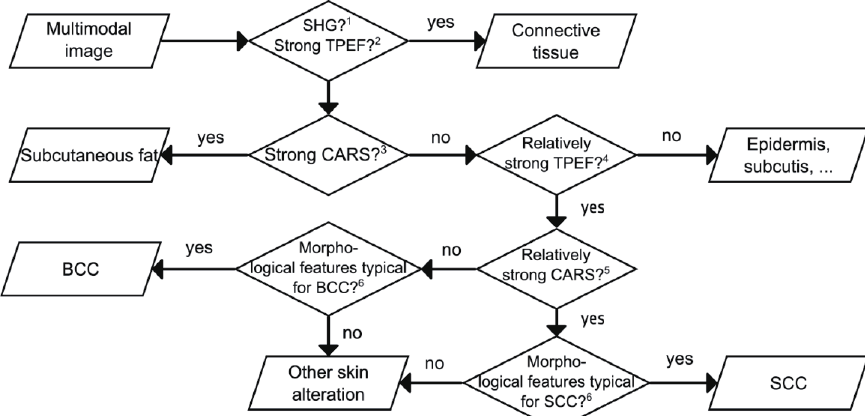
Figure 6. Flow chart suggesting a pathway for manual NMSC diagnosis analyzing multimodal images. It might form the basis for a future computerized discrimination of NMSC and healthy tissue. For a detailed explanation see the